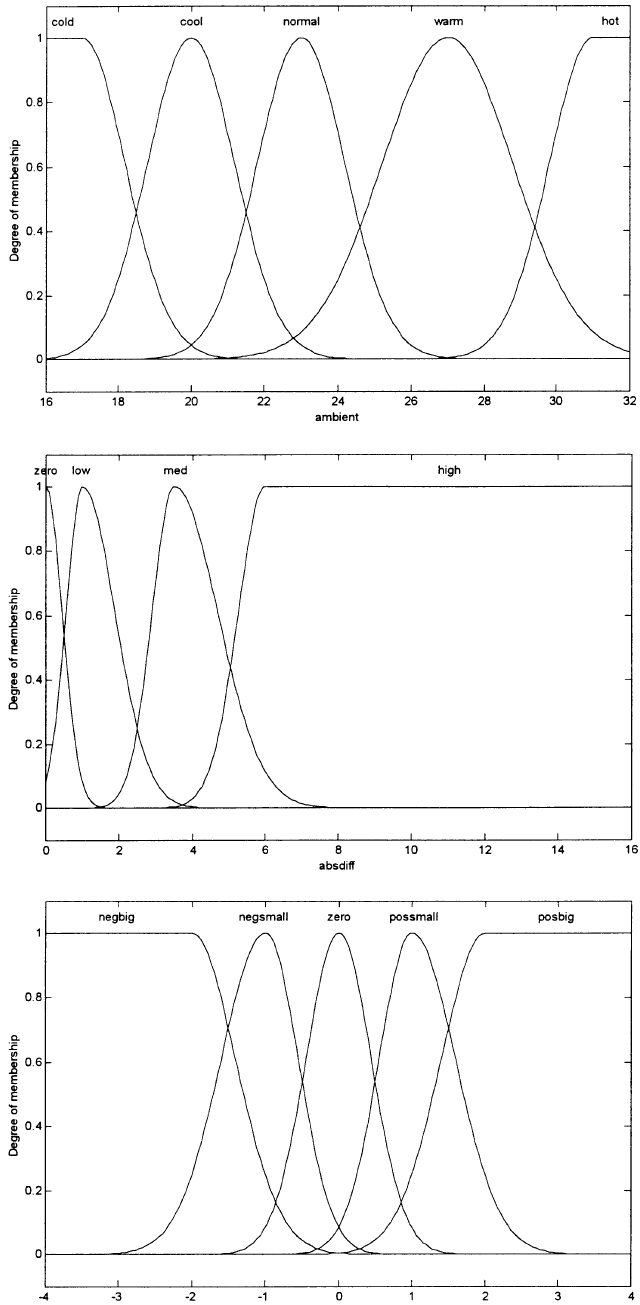
FIGURE 3 Input linguistic terms and corresponding membership